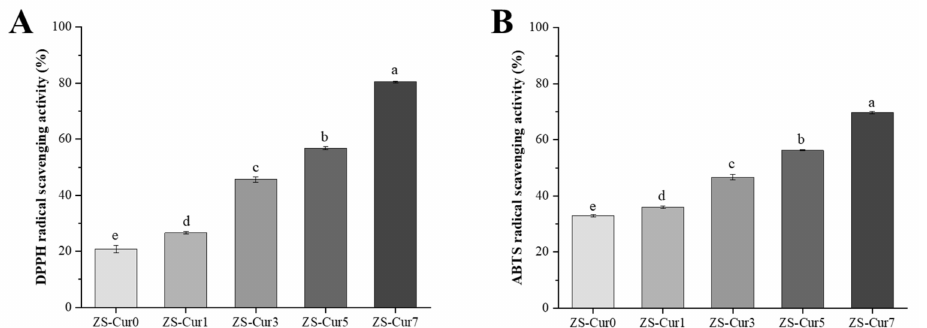
Figure 6. ( A ) DPPH and ( B ) ABTS radical scavenging activity of ZS–Cur films. Different superscript letters indicate significant differences ( p <